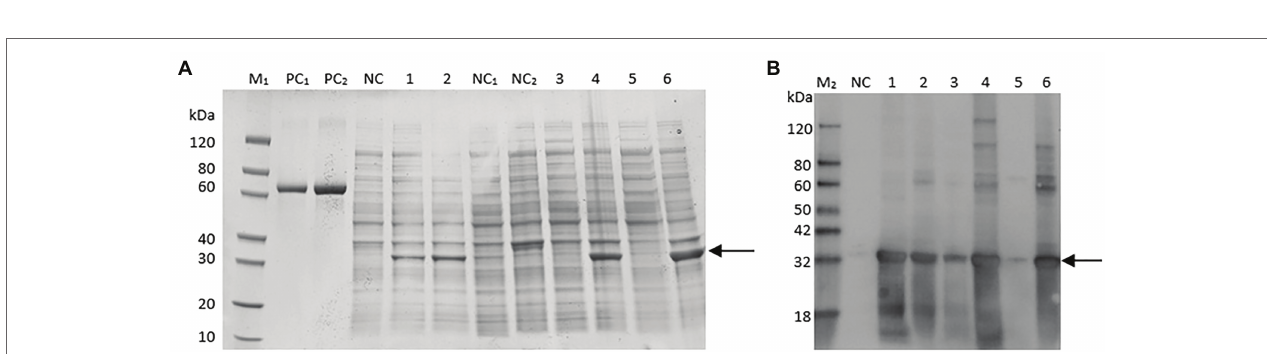
FIGURE 2 | Sulfate-polyacrylamide gel electrophoresis (SDS-PAGE) (A) and Western blot (B) analysis for ct cloned in pET30a (+) and expressed in BL21 (DE3) strain. Markers (bovine serum albumin: PC, protein marker: M1, Western blot marker: M2) are shown in the left column. Lanes 1, 3, and 5 represent cell lysate, supernatant of cell lysate, and debris of cell lysate, respectively, of Escherichia coli cells containing the expression vector inducted for 16 h at 15 ° C. Lanes 2, 4, and 6 represent cell lysate, supernatant of cell lysate, debris of cell lysate, respectively, of recombinant E. coli cells induced by IPTG for 4 h at 37 °